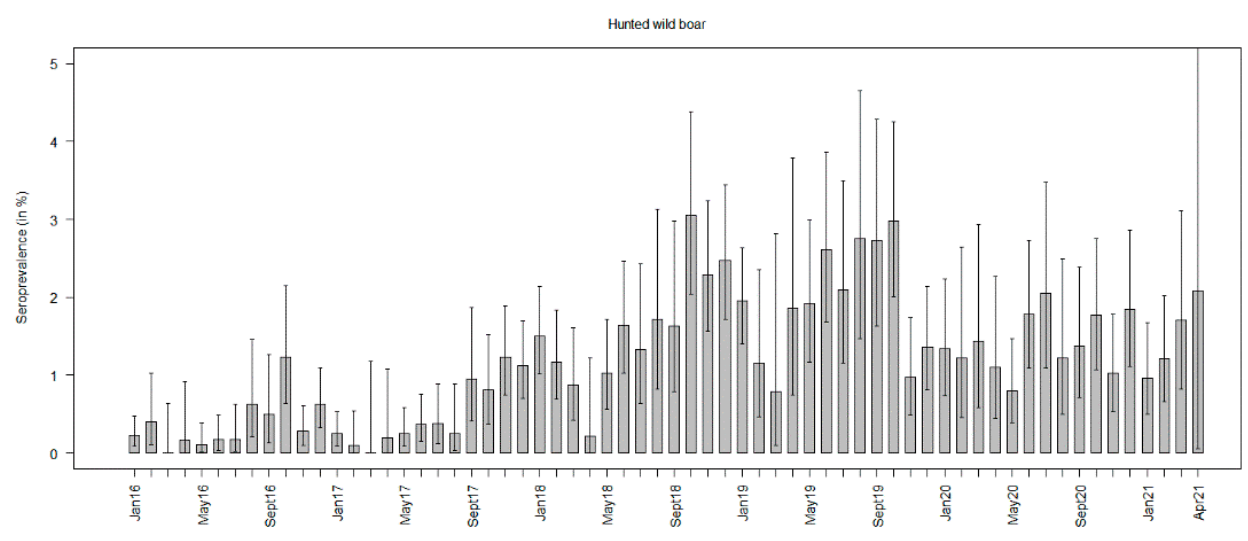
Figure 6. African swine fever virus-specific antibody prevalence estimates (seroprevalence) in hunted wild boar per month from January 2016 to April 2021.